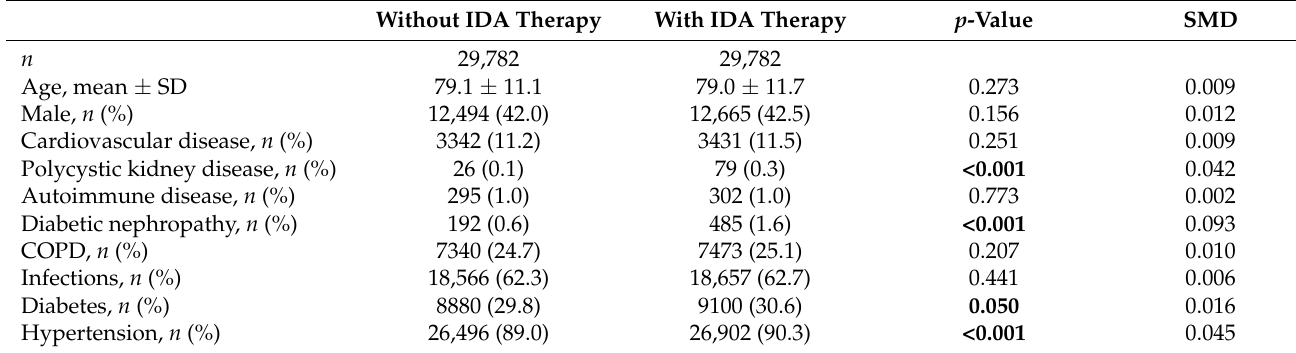
Table 1. Demographic and clinical characteristics of IDA-ND-CKD during the characterization period, by the presence of IDA therapy, post PSM. Significant p -values are highlighted in bold.